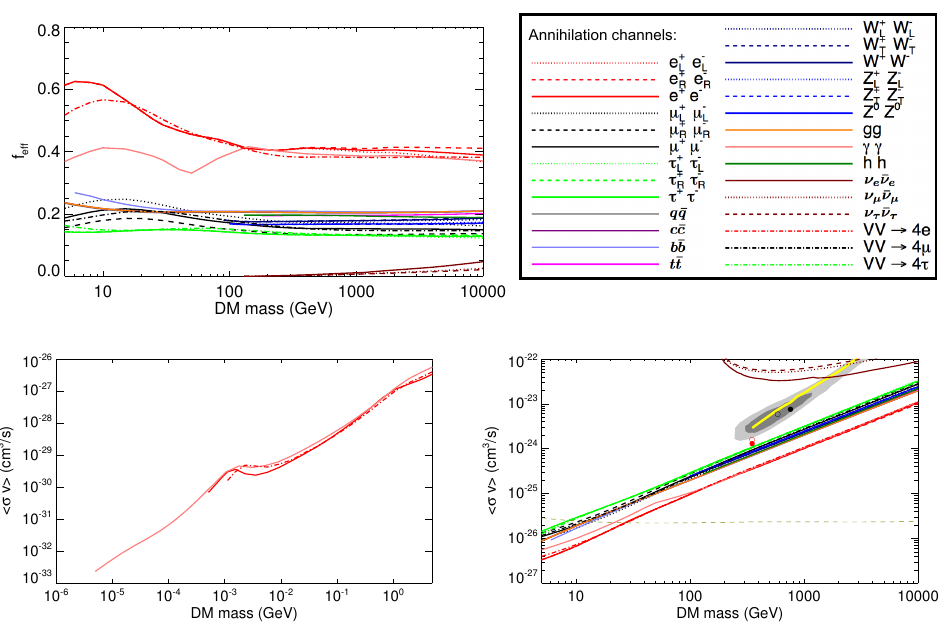
Figure 4: The upper panel shows the f coefficients as a function of DM mass for eff each of a range of SM final states, as indicated in the legend. The V V → 4 X states correspond to DM annihilating to a pair of new neutral vector bosons V , which each subsequently decay into e + e − , µ + µ − or τ + τ − (labeled by X ). The lower panels show the resulting estimated constraints from recent Planck results [ 62 ] , as a function of DM mass, for each of the channels. The left panel covers the range from keV-scale masses up to 5 GeV, and only contains results for the e + e − , γγ and V V → 4 e channels; the right panel covers the range from 5 GeV up to 10 TeV, and covers all channels pro- vided in the PPPC4DMID package [ 29 ] . The light and dark gray regions in the lower right panel correspond to the 5 σ and 3 σ regions in which the observed positron fraction can be explained by DM annihilation to µ + µ − , for a cored DM density pro- file (necessary to evade γ -ray constraints), taken from Ref. [ 63 ] . The solid yellow line corresponds to the preferred cross section for the best fit 4-lepton final states identified by Ref. [ 64 ] , who argued that models in this category can still explain the positron fraction without conflicts with non-observation in other channels. The red and black circles correspond to models with 4 e (red) and 4 µ (black) final states, fitted to the positron fraction in Ref. [ 65 ] ; as in that work, filled and open circles correspond to different cosmic-ray propagation models. The near-horizontal dashed gold line corresponds to the thermal relic annihilation cross section [ 66 ] . Reproduced from Ref. [ 5 ]